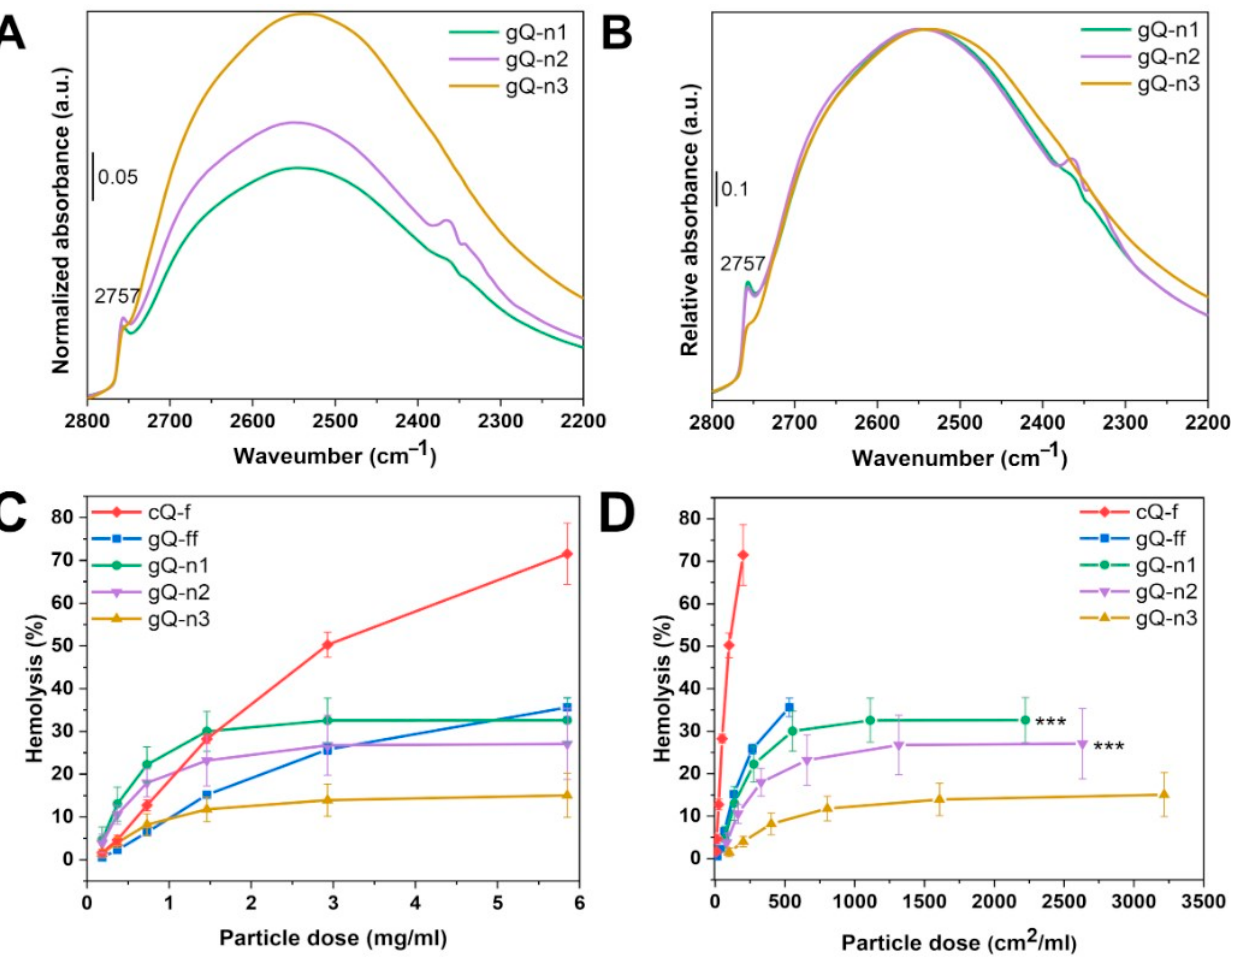
Figure 8. Surface silanol distribution of nanoquartz samples (gQ-n1, gQ-n2, and gQ-n3). Transmit- tance FTIR spectra in the 2200–2800 cm − 1 range ( ν Si-OD region) were collected at b.t. after H/D isotopic exchange and subsequent outgassing for 120 min. Spectra were normalized by the bulk mode and the SSA of the particles ( A ) or by the number of interacting silanols ( B ). Hemolytic activity of fine-fractured (gQ-ff) and nanoquartz samples (gQ-n1, gQ-n2, and gQ-n3), reported as function of the particle mass ( C ) or particle exposed surface area ( D ). A mined fractured quartz (cQ-f) was used as positive reference particle for the test. Data are mean ± s.d. of three independent experiments; p values of gQ-n1 and gQ-n2 compared to gQ-n3 determined by two-way ANOVA followed by Tukey’s post hoc test (mean effect): *** p <